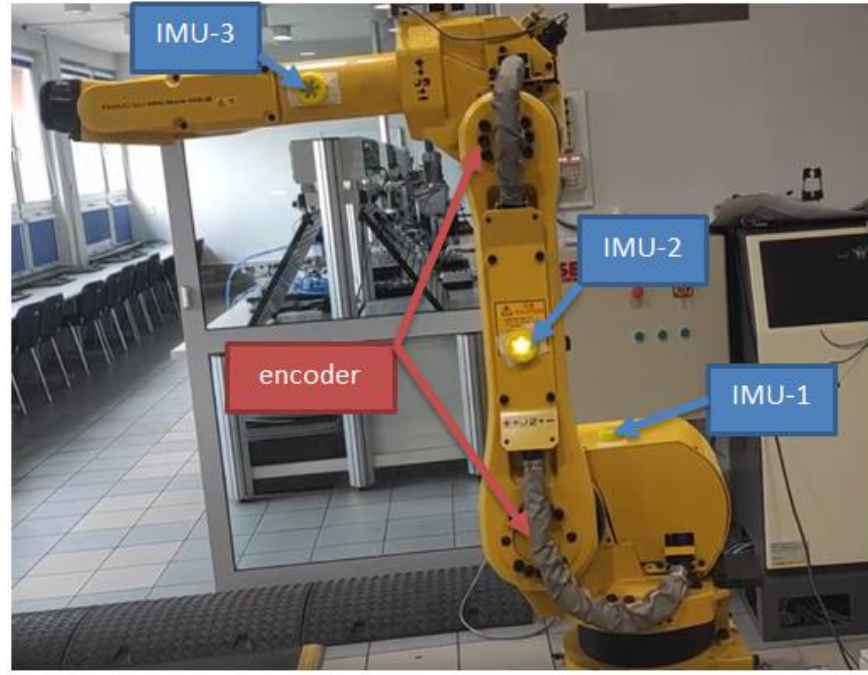
Figure 1. FANUC ARC Mate 100iB industrial robot with marked IMU sensors and encoders.